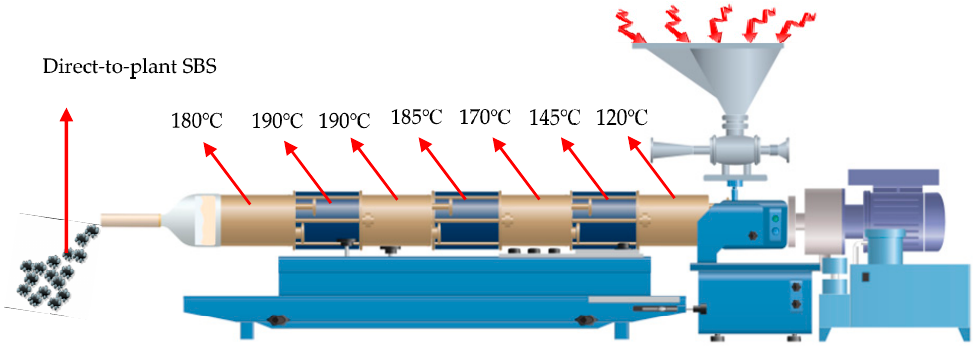
Figure 1. The preparation process of direct-to-plant SBS modifier.